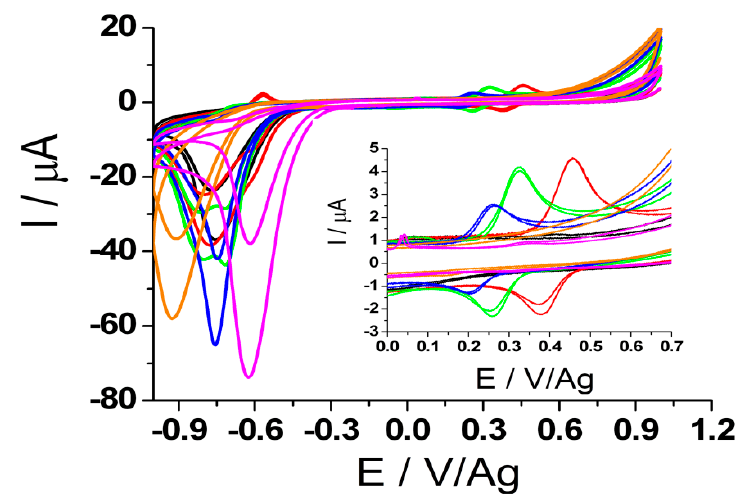
Figure 1. Cyclic voltammograms of 54.35 µ g/mL (100 µ M) DOX in: acetate buffer (AB) of pH 3.23 (red), 4.5 (green), 5.53 (blue), citrate buffer (CB) of pH 6.77 (orange), phosphate buffer saline (PBS) of pH 7.2 (magenta), recorded at SWCNTs modified graphite electrode (scan rate: 100 mV/s, potential range: ( − 1, +1 V)/Ag).